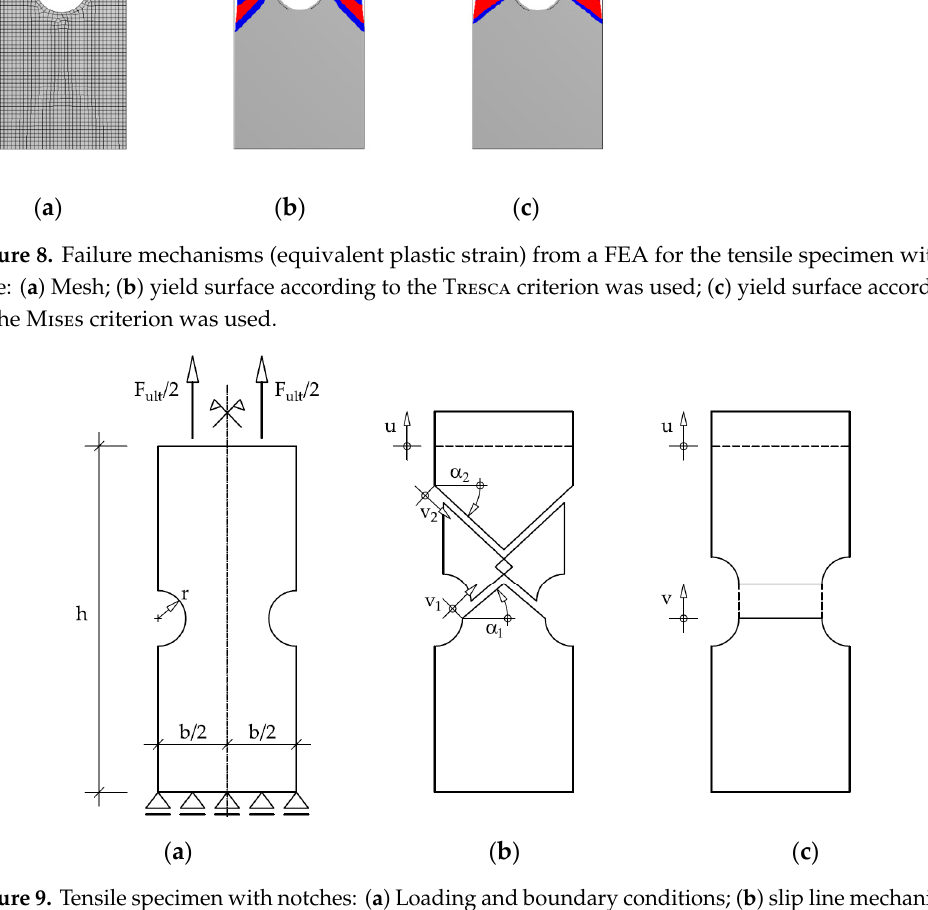
Figure 9. Tensile specimen with notches: ( a ) Loading and boundary conditions; ( b ) slip line mechanism; ( c ) yield zone mechanism.